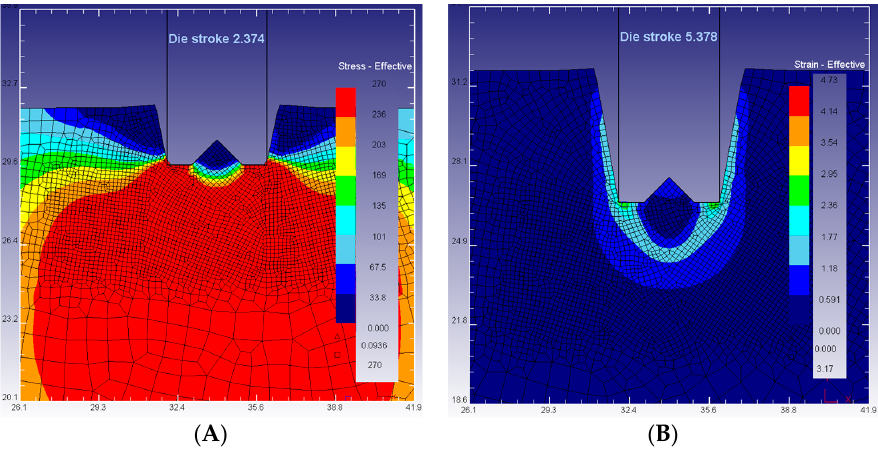
Figure 12. Geometry 3 analysis. Strain ( A ) and stress ( B ) during deformation.